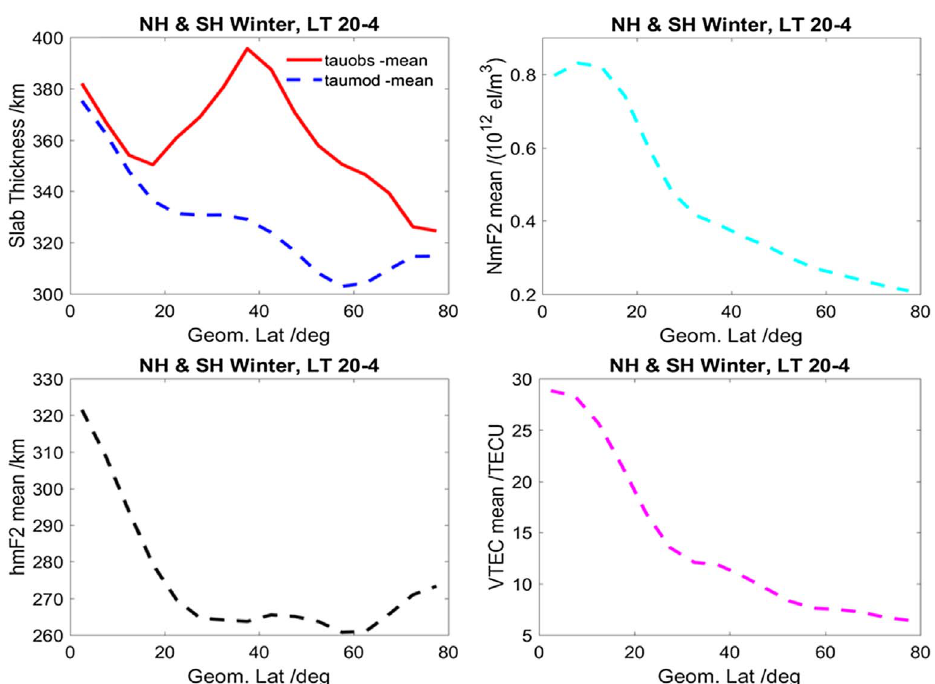
Fig. 16. Latitudinal dependences of globally averaged nighttime behavior of equivalent slab thickness, peak electron density NmF2, Peak height hmF2 and vertical total electron content VTEC during winter time, averaged over both hemispheres (time interval: 20 – 04 LT, years 2001 – 2018). The equivalent slab thickness observations are compared with corresponding model values (top left, dashed blue